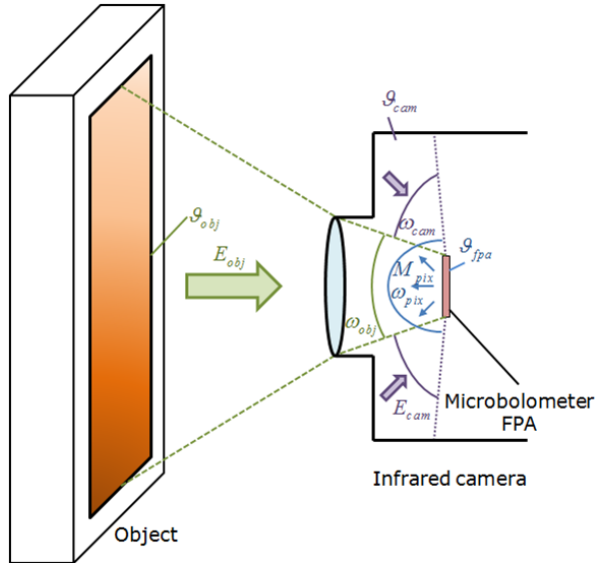
Figure 2. Radiation components in an infrared camera. E obj radia- tion derived from the object depending on its temperature ϑ obj cov- ering the projected solid angle ω obj , E cam radiation from the camera interior related to the camera temperature ϑ cam and the solid angle ω cam , as well as the radiant exitance M pix of the sensor depend- ing on the sensor temperature ϑ fpa emitted into the projected solid angle ω pix .